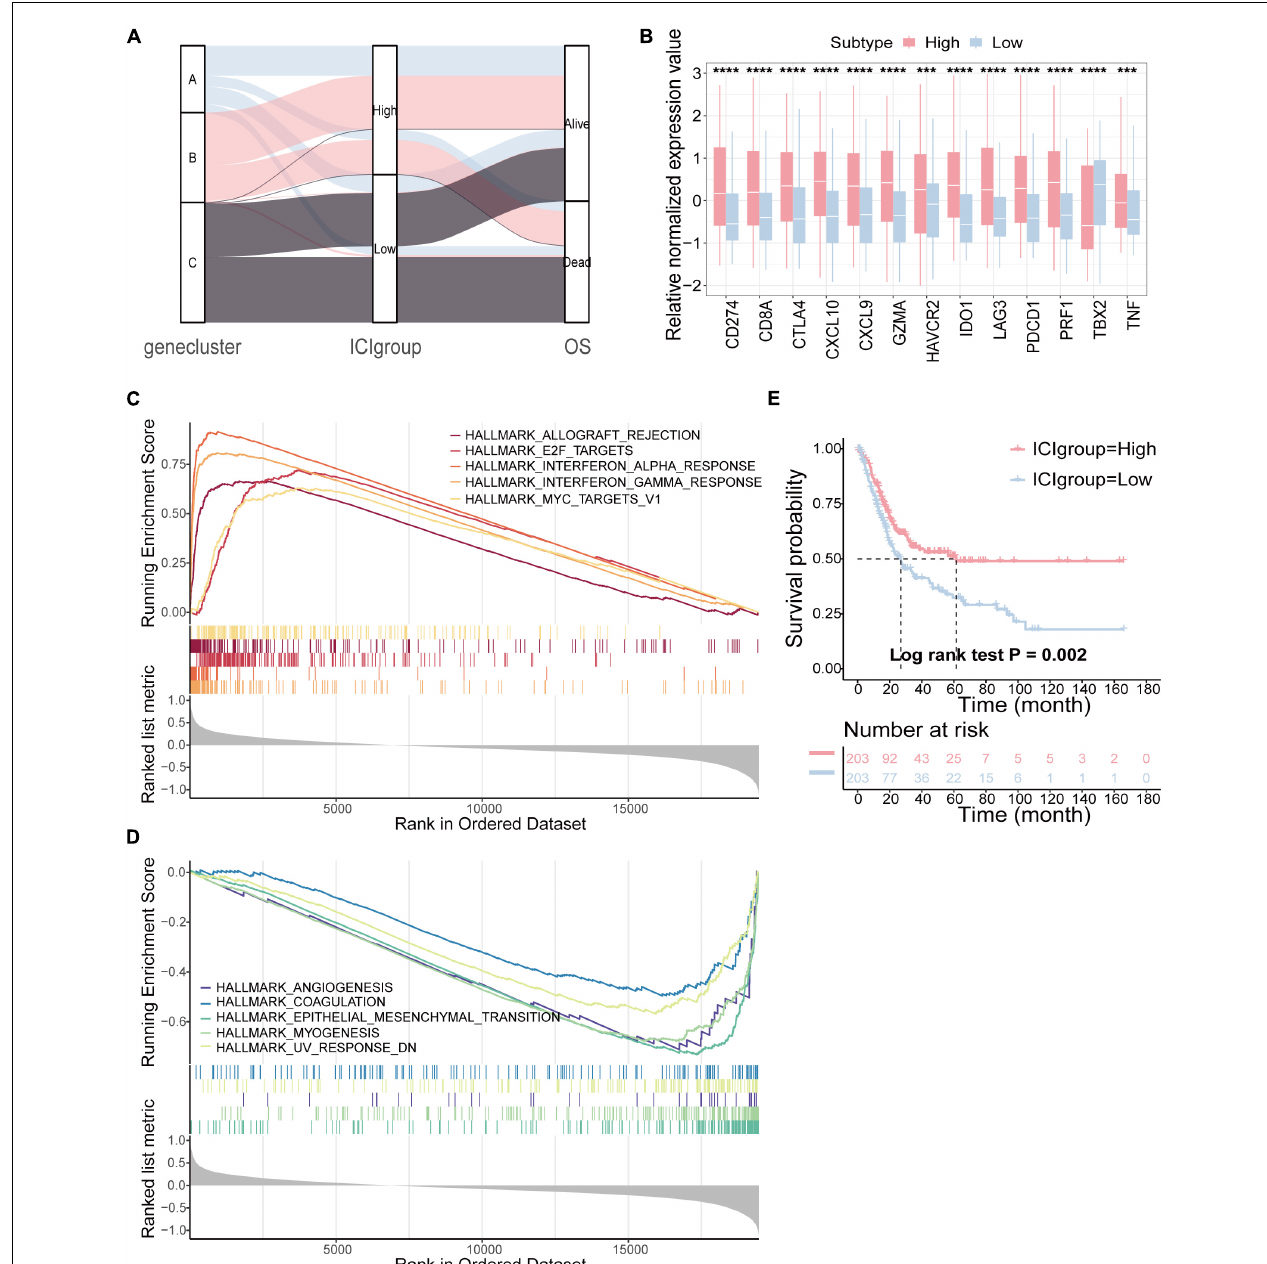
FIGURE 3 | Construction of the ICI score. (A) Alluvial diagram of gene cluster distribution in groups with different ICI score and survival outcomes. (B) The difference in the expression of immune checkpoint-related genes (IDO1, CD274, HAVCR2, PDCD1, CTLA4, and LAG3) and immune activity-related genes (CD8A, CXCL10, CXCL9, GZMA, PRF1, TBX2, and TNF) between high and low ICI score subgroups. (C,D) The gene set enrichment analysis (GSEA) in high (C) and low ICI score subgroups (D) . (E) Kaplan–Meier curves for high and low ICI score groups in the TCGA-BLCA cohort (log-rank test, p = 0.002). *** p < 0.001; **** p <